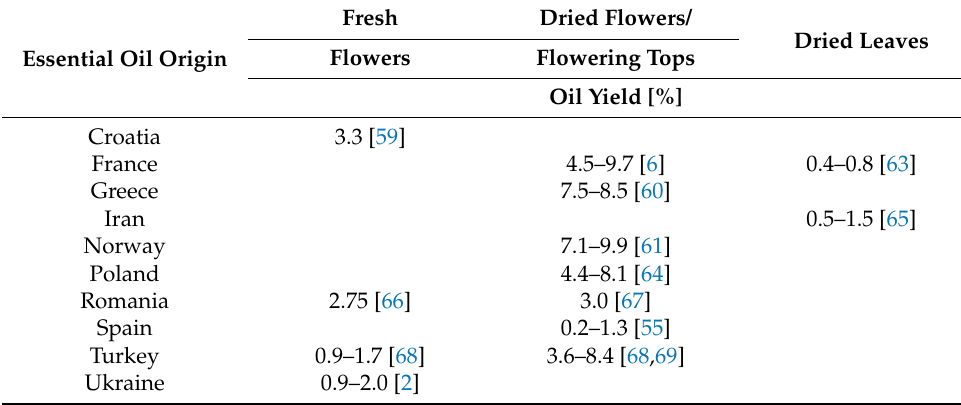
Table 4. L. × intermedia essential oil yield from different plant